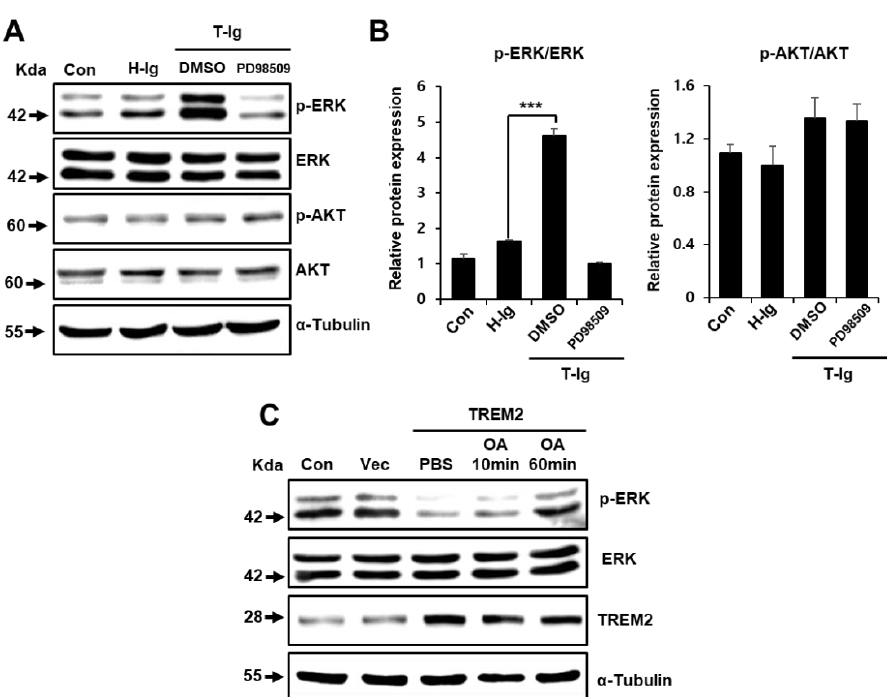
Figure 4. TREM2 downregulates the extracellular signal-regulated kinase (ERK) signaling pathway. ( A ) The indicated protein expression levels in HT29 cells treated with H-Ig or T-Ig (2 µ g / mL) or PD98509 ( 10 μM ) for 10 min were analyzed by Western blot. ( B ) The relative protein expression was quantitatively analyzed by densitometry. ( C ) HT29 cells were transfected with plasmids containing the TREM2 gene or vector and treated with OA (10 nM) for 10 min or 1 h, and phosphorylation levels of ERK were analyzed by Western blot. The data are representative of three independent experiments (*** p <